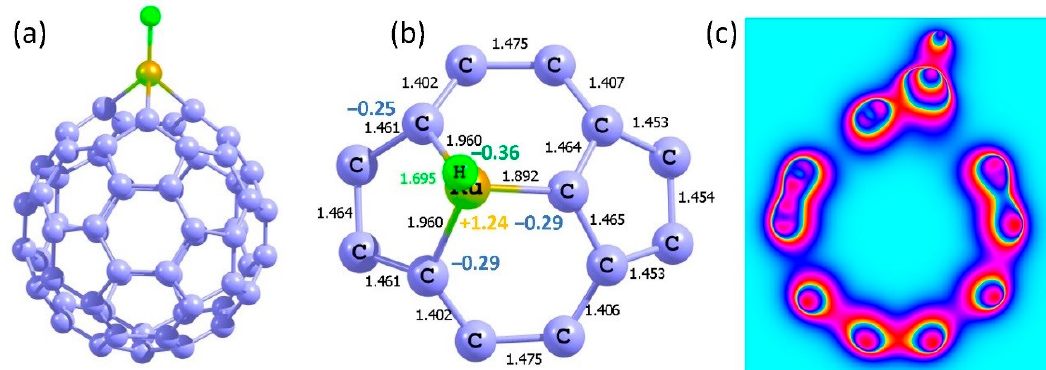
Figure 10. ( a ) Relaxed structure of a single hydrogen adsorbed on the Ru-doped C 60 surface, ( b ) bond distances and Bader charges on the Ru and its adjacent C atoms and ( c ) charge density plot showing the interaction between a single hydrogen atom and Ru-doped C 60 surface.